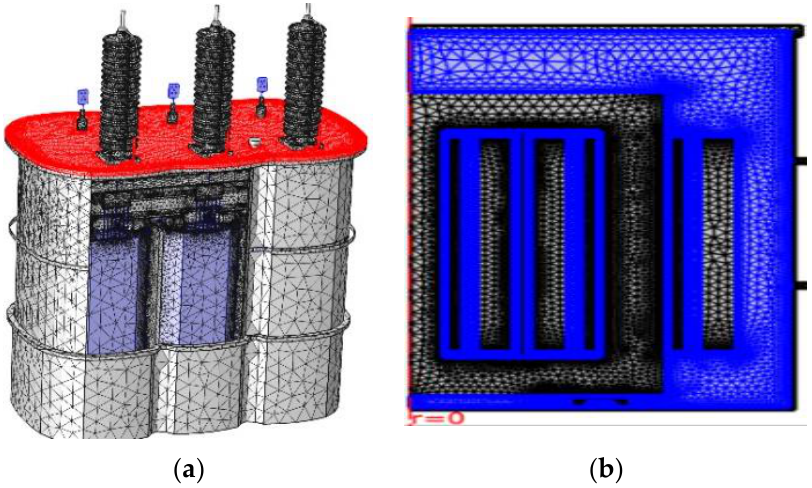
Figure 8. Meshed structure of the; ( a ) 3D transformer model; ( b ) 2Daxi transformer